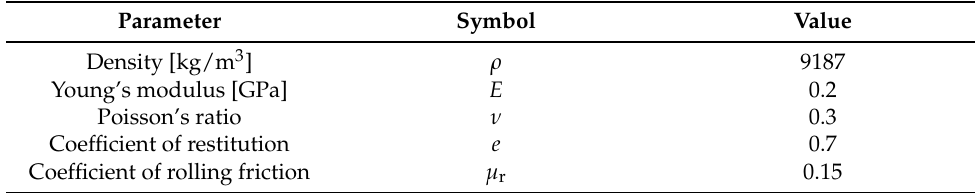
Table 2. Material properties used in the